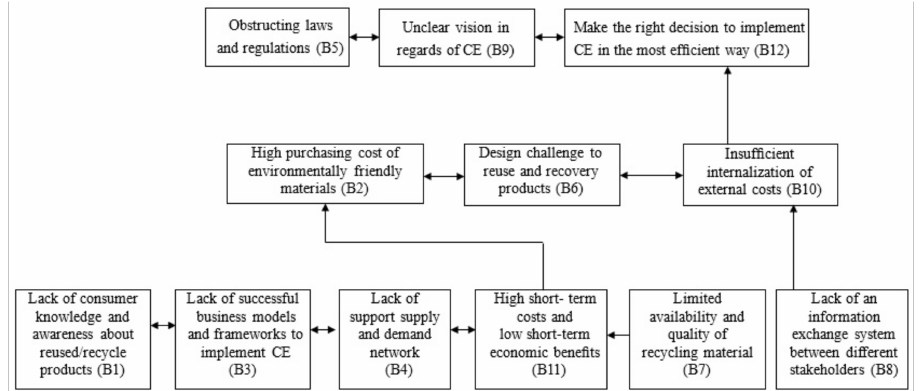
Figure 3. ISM network for CE adoption obstacles.